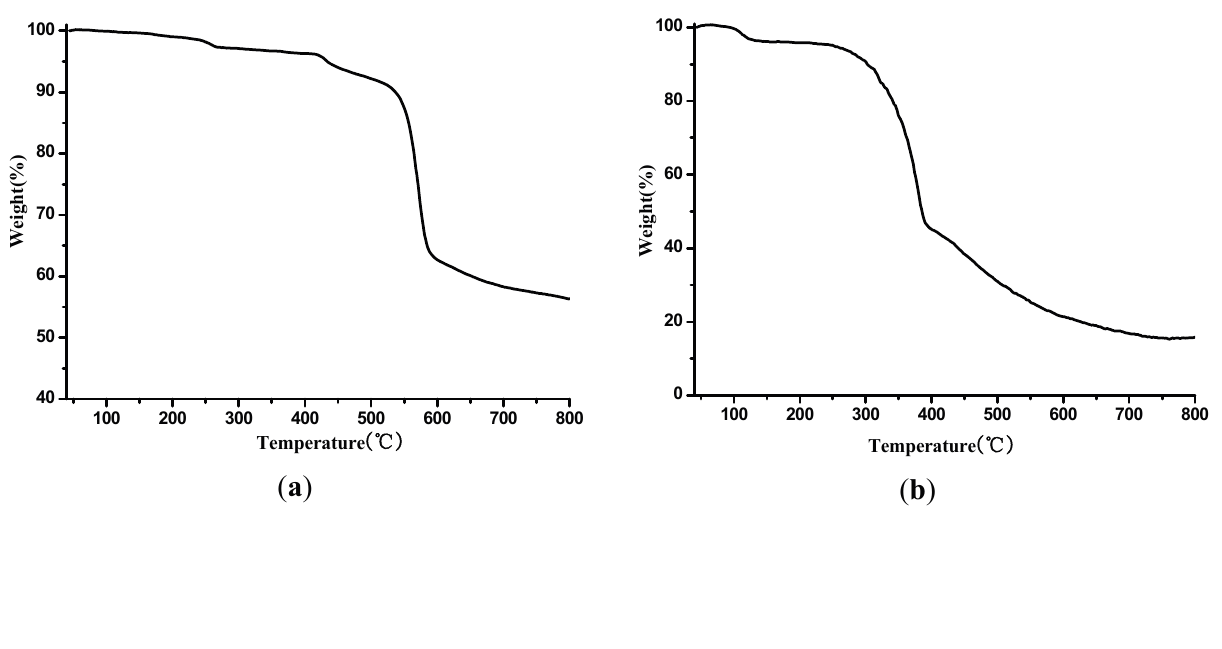
Figure 7. ( a , b ) Thermogravimetric curve of complexes 1 and 2